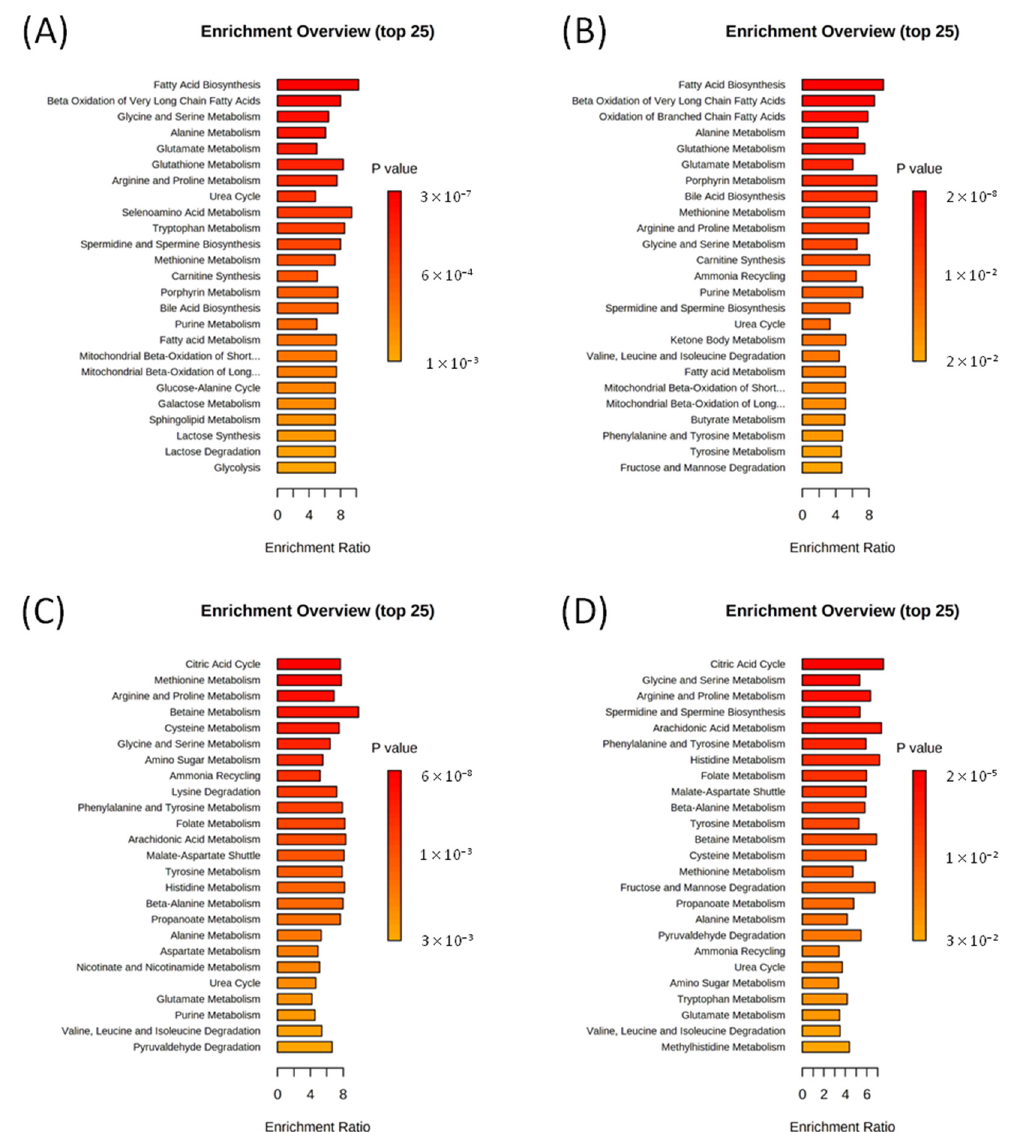
Figure 5. Summary plots for quantitative enrichment analysis (MSEA) based on the comparison of serum metabolomic compositions: of fasting and control Wistar ( A ) and OXYS ( B ) rats; of CQ-treated and control Wistar ( C ) and OXYS ( D ) rats.